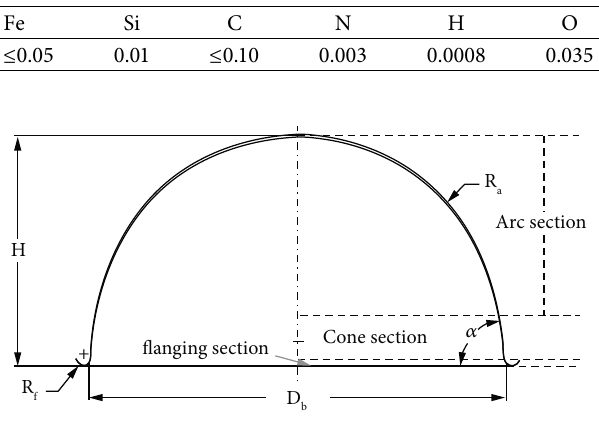
Figure 2: Basic structure of a common titanium